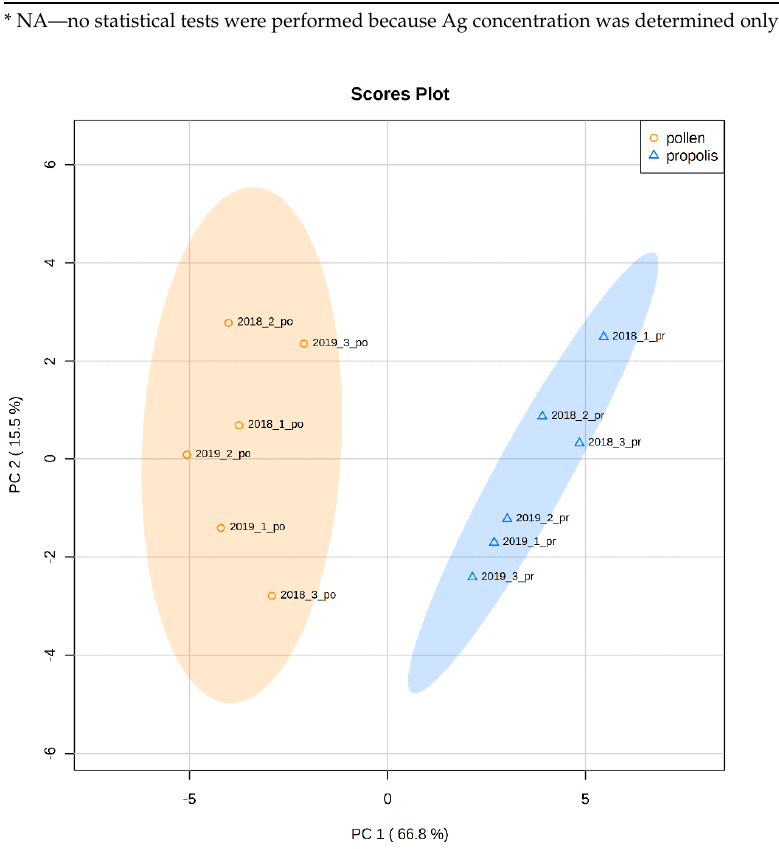
Figure 1. The principal component analysis (PCA) score plot using the first two principal components derived from elements’ determination in two beehive products: bee pollen (orange circles; n = 6) and propolis (blue triangles; n = 6). Table 3. Results of univariate tests performed to compare levels of chemical elements ( n = 24) in two beehive products collected over two years from the same area: bee pollen and propolis. Bold text indicates a statistically significant difference with a p -value below 0.05.